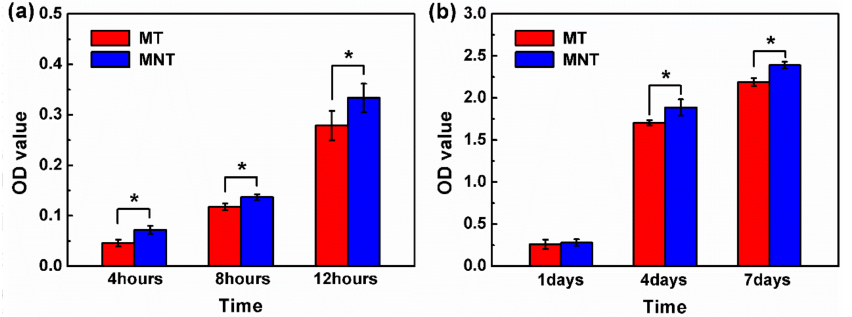
Figure 11. Adhesion of the hBMSCs on MT and MNT after 4, 8, 12 h ( a ); proliferation of hBMSCs on MT and MNT after 1, 4, 7 days ( b ). (* represents p <